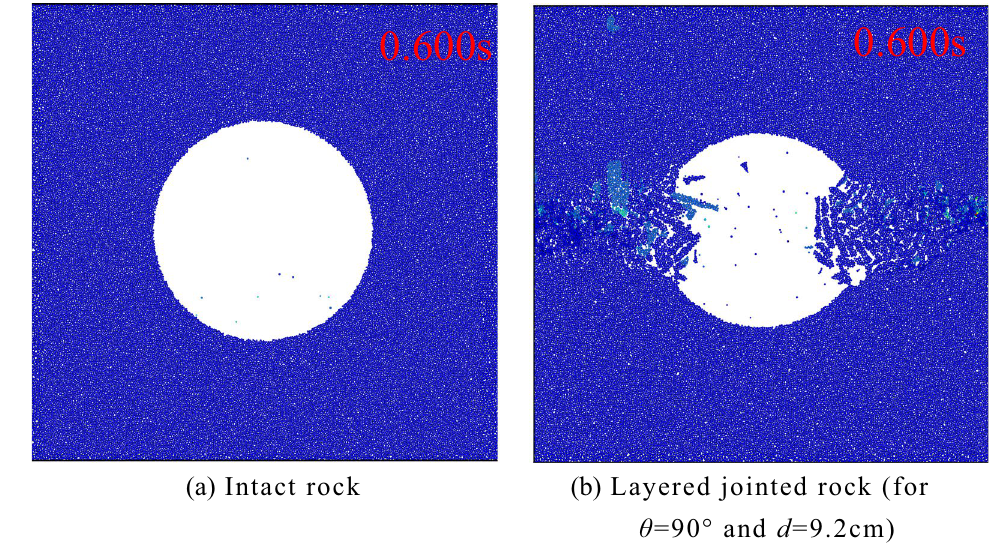
Fig. 8 Comparison diagram of failure results (for σ